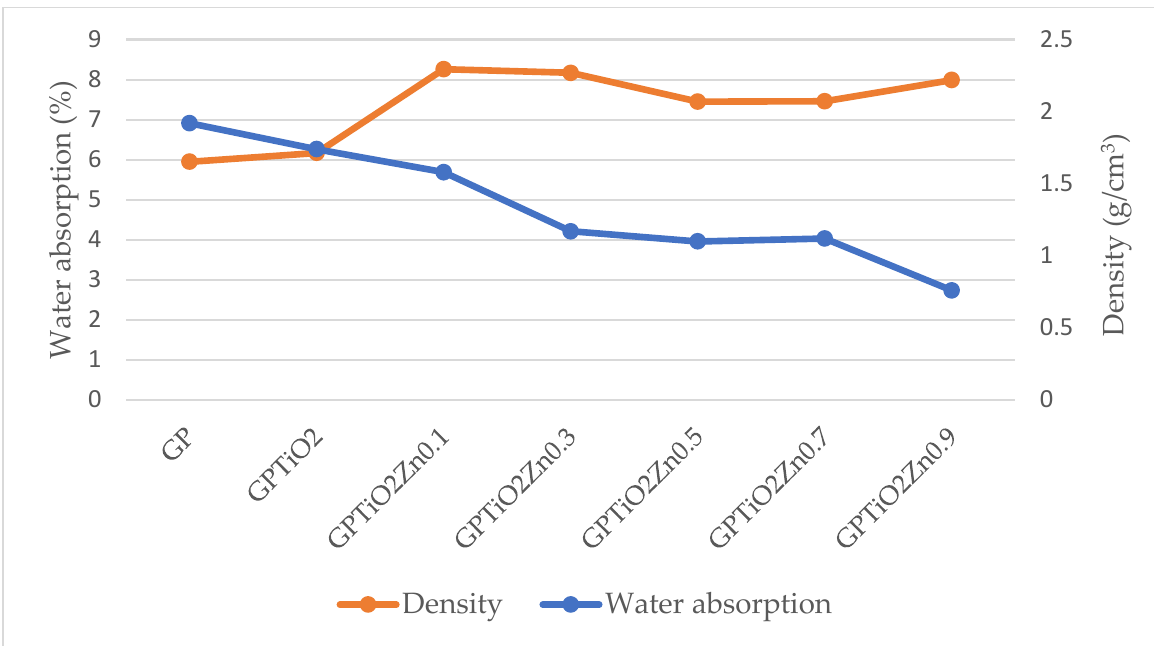
Figure 9. Water absorption versus density of metakaolin geopolymer coating paste.